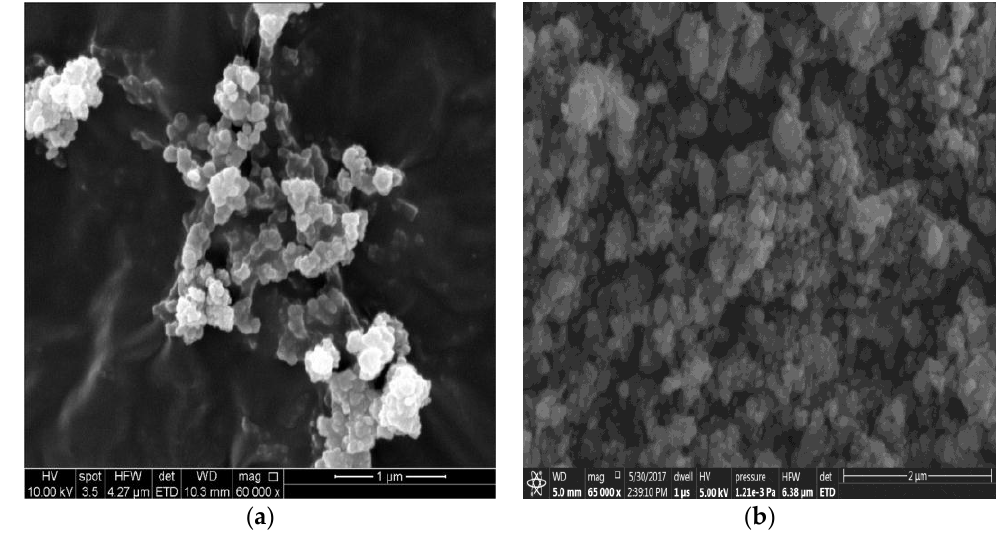
Figure 2. Scanning electron microscopy (SEM) images for ( a ) UiO-66 and ( b ) MIL-125 MOFs nanoparticles (NPs).